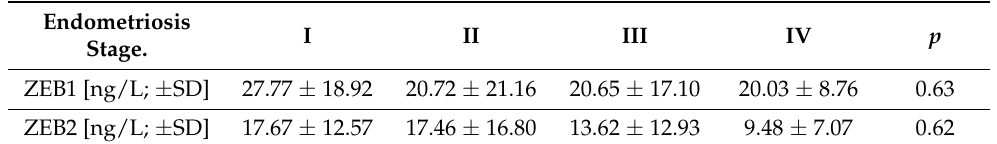
Table 2. Zinc finger E-box-binding homeobox 1 (ZEB1) and Zinc finger E-box-binding homeobox 2 (ZEB2) plasma concentrations depending on the stage of endometriosis.